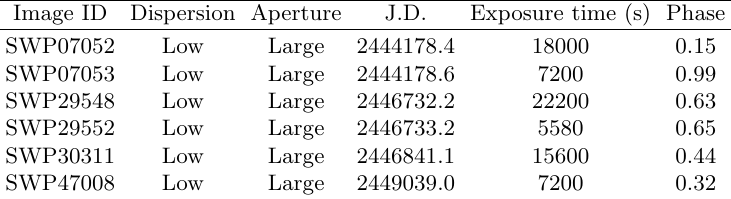
Table 2. Journal of IUE observations of AN UMa.